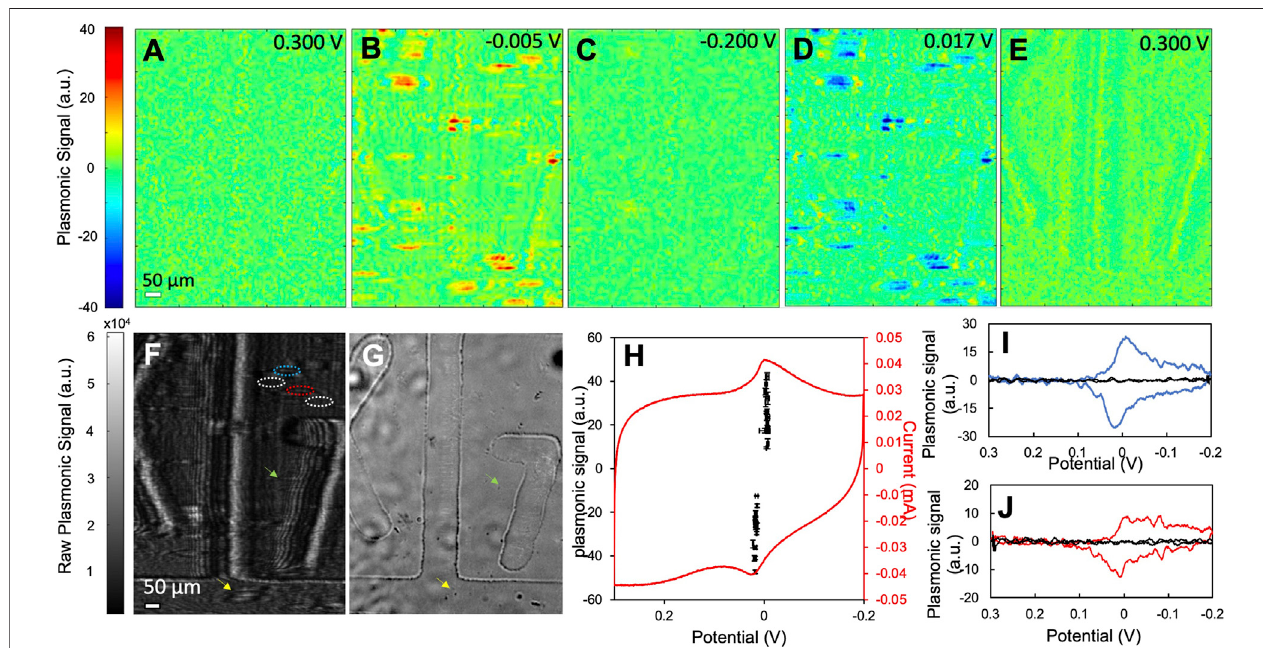
FIGURE3| TheelectrochemicalactivityoftypeIPBNPs. (A – E) RepresentativePEMimagesoftypeIPBNPsatdifferentpotentials. (F) TherawSPRMimageoftype I PBNPs coated on a gold sensing chip with grids and (G) the bright fi eld image of the same area as (F) . (H) The potentiostat CV of the entire electrode surface and (I , J) plasmonic CVs from two PBNPs (blue and red solid lines) as labeled in (F) (blue and red dashed circled areas) and their neighboring background areas (black solid line, labeled as white dashed circled area in F) . The black data points in (H) represent the oxidation and reduction peaks ’ potentials and intensities from plasmonic CVs of 16different PBNPs. These datapoints arepresentedwith mean and standard deviation measured from four different cycles. Scanning rate: 0.05 V/s. Solution: 1.0 M